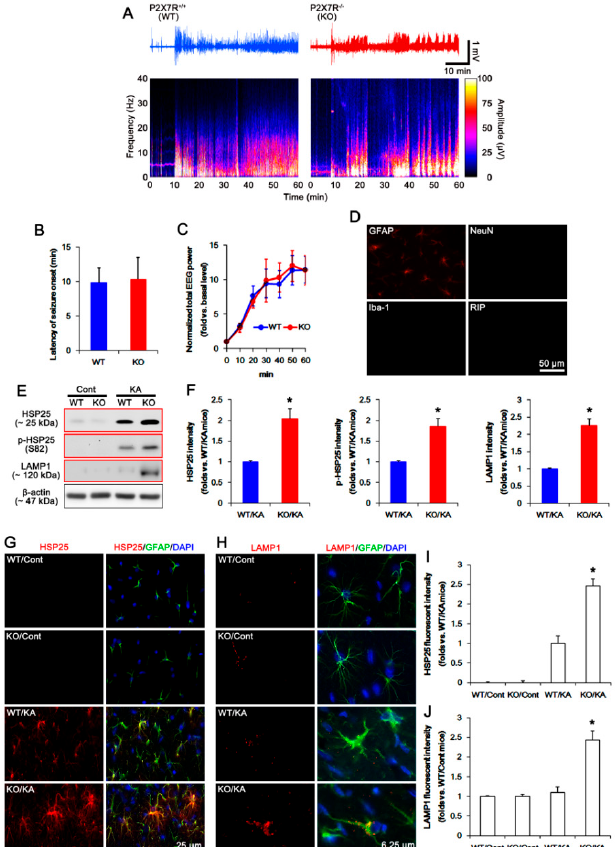
Figure 1. Effects of P2X7 receptor (P2X7R) deletion on seizure activity, heat shock protein 25